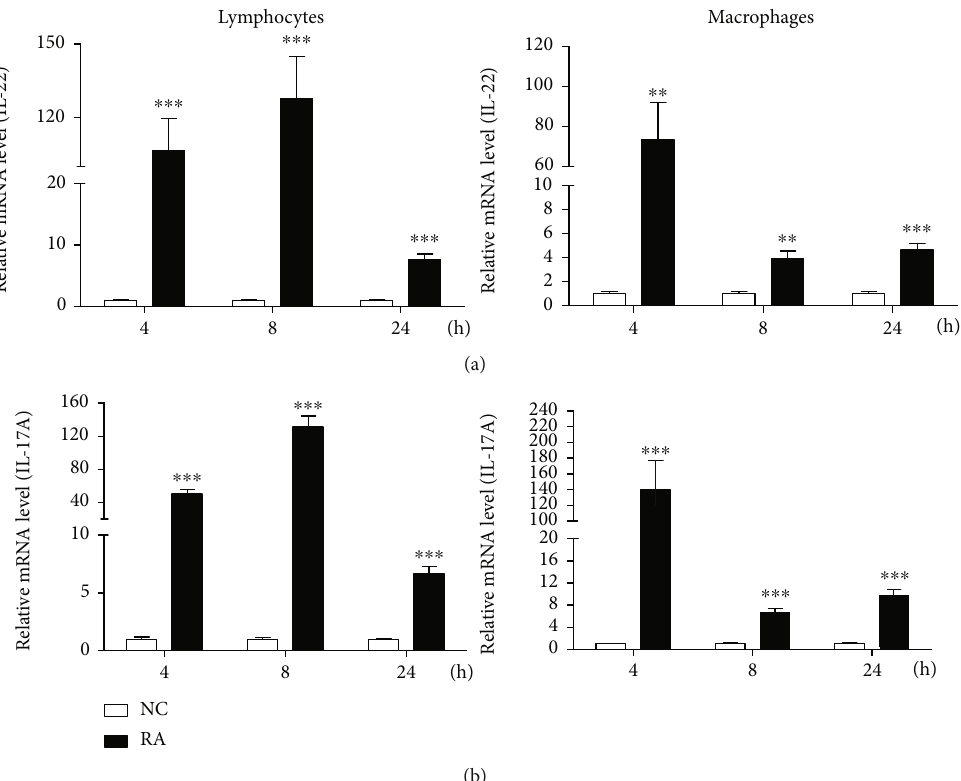
Figure 3: mRNA expression pro fi les of duck IL-22 in splenic lymphocytes and macrophages. Lymphocytes and macrophages were collected and isolated from 2-week-old healthy ducks and treated with heat-inactivated R. anatipestifer serotype 7 for the indicated times. RNA was isolated and samples were applied to qRT-PCR analysis. The transcript expression levels of IL-22 (a) and IL-17A (b) were normalized to expression levels of β -actin used as a reference gene and presented relative to the expression levels of untreated/cultured lymphocytes and macrophages (NC). Results are presented as the mean ± SE values from 3 independent experiments performed in triplicate. ∗∗ P < 0 : 01 and ∗∗∗ P < 0 : 001 . RA: R. anatipestifer -stimulated